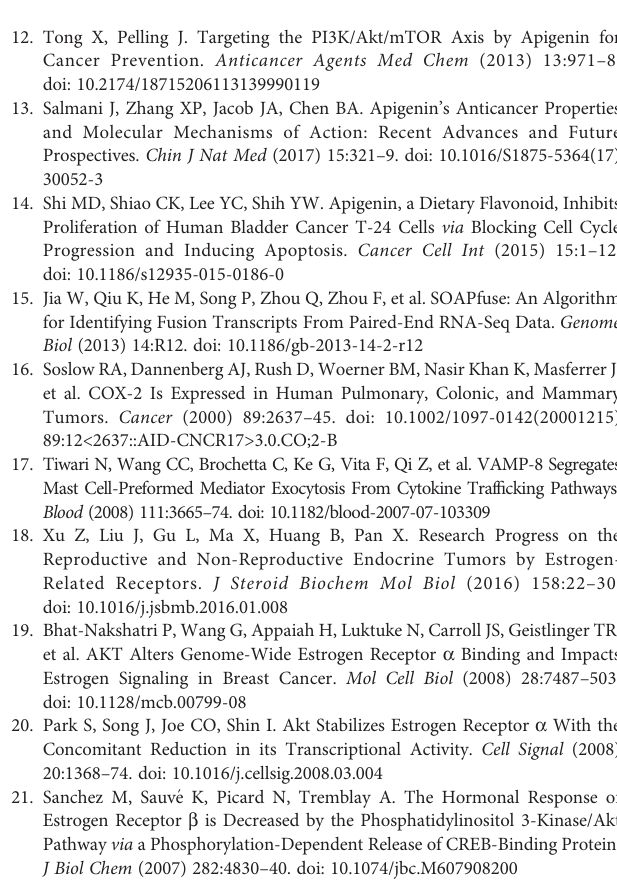
Supplementary Figure 3 | The mRNA expression of HRH1 (A) and HRH3 (B) after HA, AZD9496 DNP and APG treatment. * P < 0.05 (Compared to untreated OVCAR-3 cell